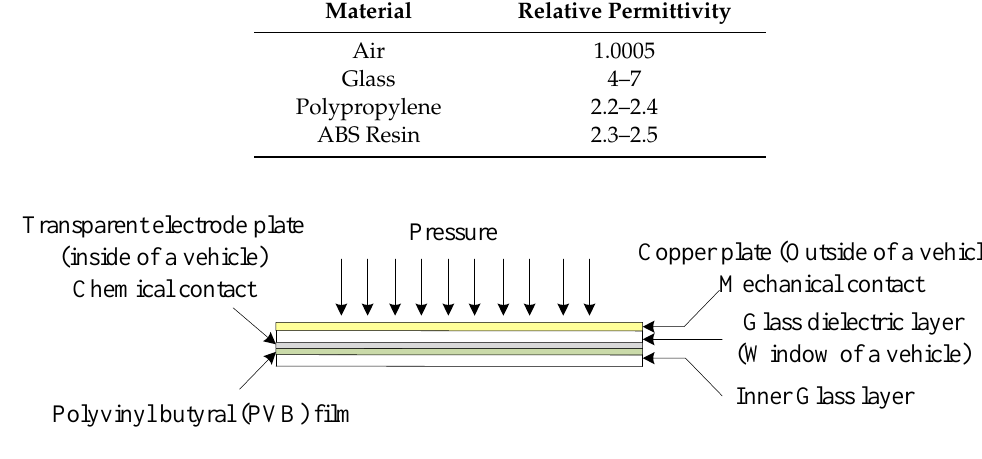
Figure 2. Coupling capacitor implementation in a vehicle.